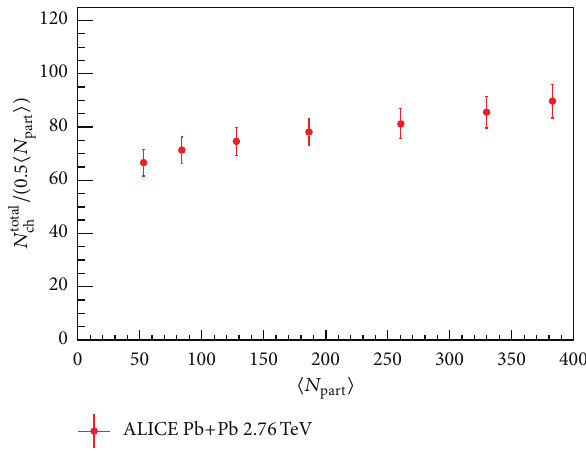
Figure 21: 𝑁 total normalized to participant pair as a function of 𝑁 ch = 2.76 TeV. for Pb+Pb collisions at √𝑠 NN